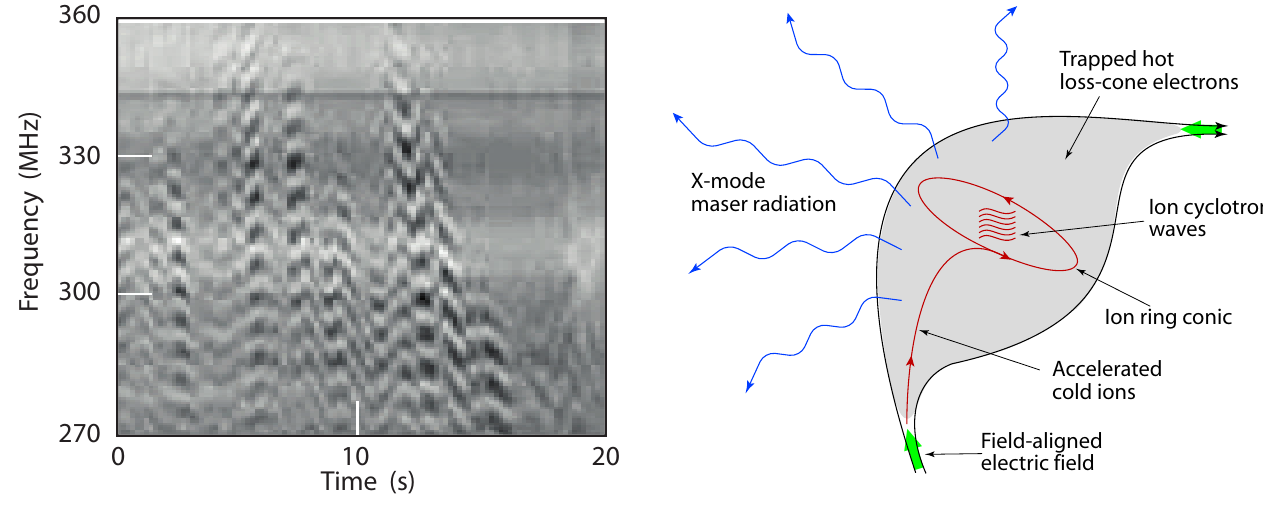
Fig. 1. A typical example of a non-drifting Zebra emission pattern on a weakly variable solar radio continuum background. Shown is the frequency-time spectrogram of the a brief part of the originally observed emission (data taken from Chernov, 2010). We have chosen only 20s of observation and cut out 90MHz in frequency in the metric wavelengths range. The typical Zebra pattern comes out clearly on the linear frequency scale consisting of many equally spaced chains of consecutive emission and absorption bands. The radio antenna seems to snapshot different emission sites at differ- ent times and for different length of time. Some such sites exhibit frequency drifts in either direction from high to low but also from low to high frequencies. When emissions from two (or more) sites are detected at same time as on the right, then patchy structures are created according to the constructive or destructive interference of emissions.